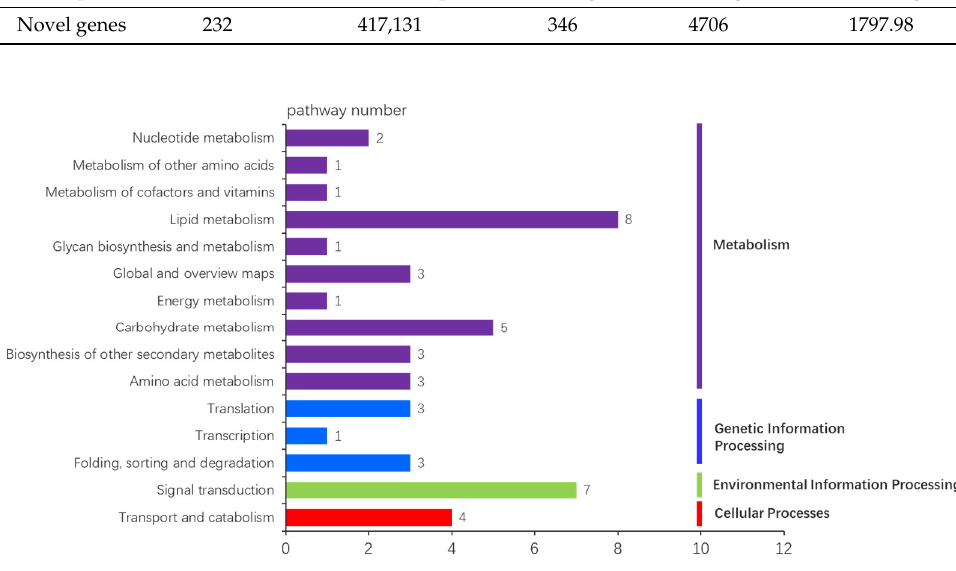
Figure 8. The unique pathway number of novel genes in KEGG database.